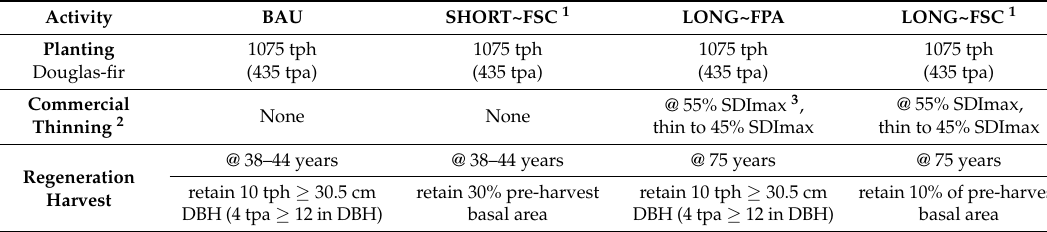
Table 1. Silvicultural systems 1 and treatments applied to each of the parcels.